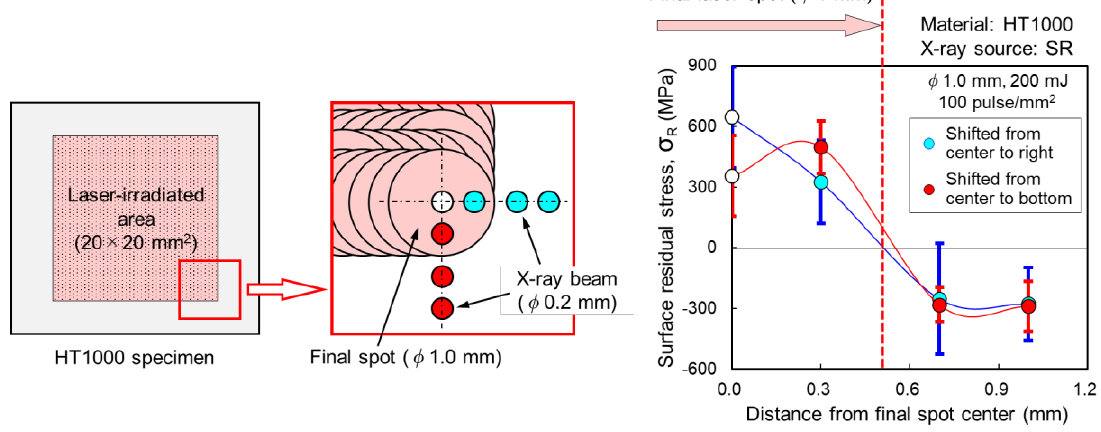
Figure 9. Surface RS distribution across the final spot irradiated in the 2D area.